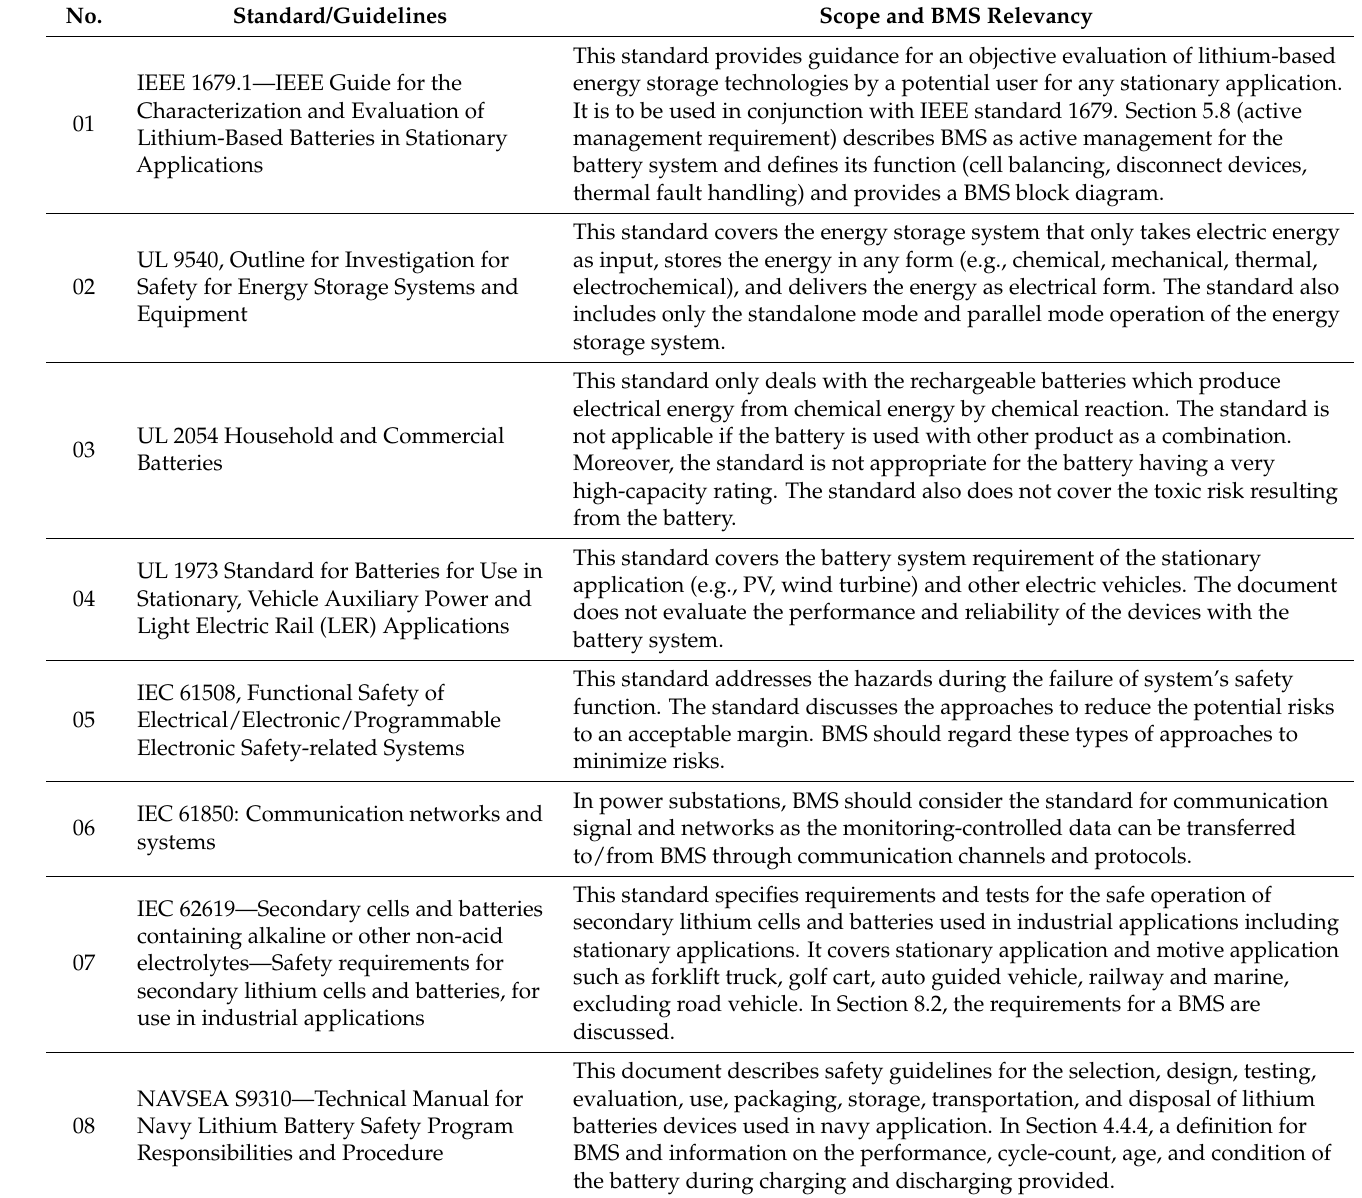
Table 6. Relevant standards/guidelines for large scale